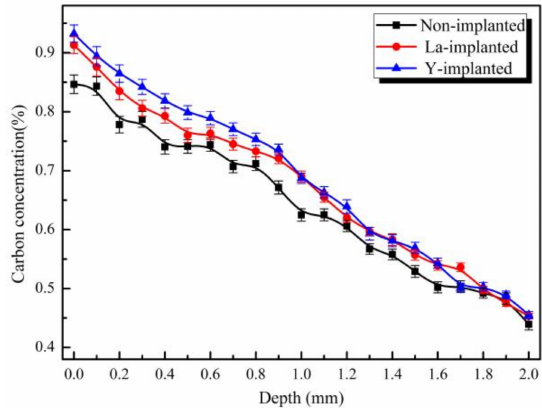
Figure 13. Carbon concentration along the depth of the carburized